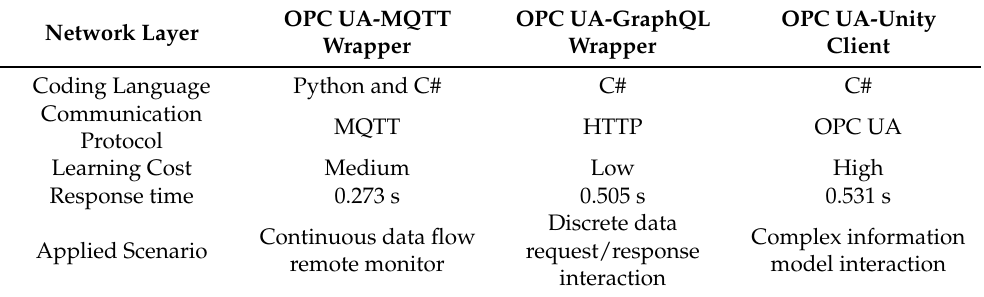
Table 5. Communication middleware comparison: coding language is the programming language needed for the development of the application in the service layer; communication protocol is applied between the network and service layer; learning cost concentrates on the service